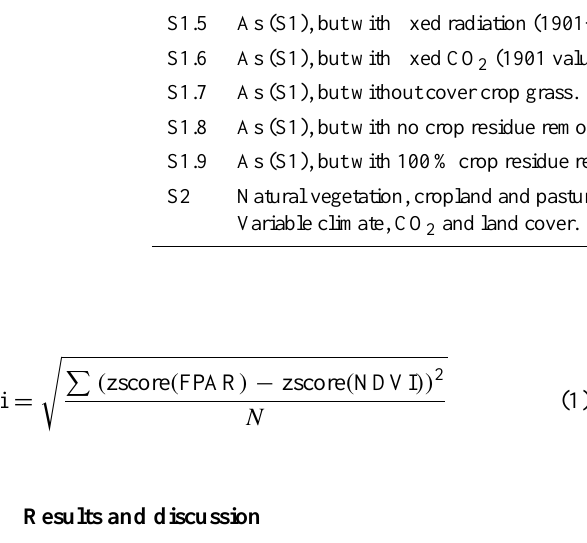
Table 3. Set-up of the different LPJ-GUESS simulations. S0 Natural vegetation only, variable climate and CO 2 . S1 Natural vegetation, explicit cropland and pasture representations, variable climate, CO 2 and land cover. Cover crop grass. Irrigated cropland. Standard harvest parameters. S1.1 As (S1), but with fixed land cover (1901 data). S1.2 As (S1), but with fixed climate (1901–1930 data cycled). S1.3 As (S1), but with fixed temperature (1901–1930 data cycled). S1.4 S1.5 S1.6